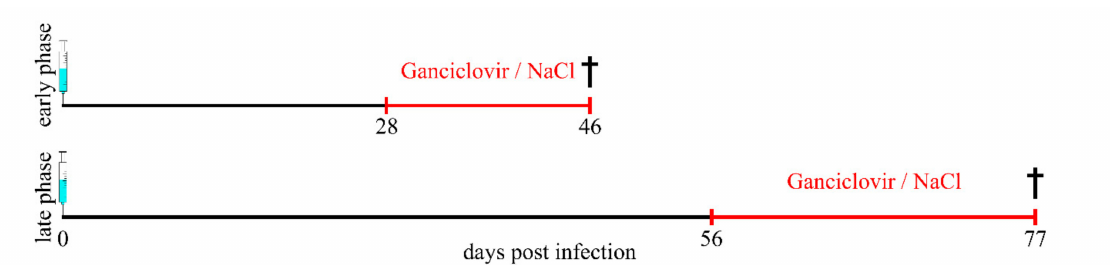
Figure 11. Study design. Groups of 2–6 GFAP-thymidine-kinase transgenic SJL mice and SJL wildtype mice were infected with Theiler’s murine encephalomyelitis virus (TMEV) or mock (vehicle only). Astrocyte depletion was induced by once daily intraperitoneal administration of ganciclovir from 28 to 46 (early phase) or 56 to 77 (late phase) days post infection. Red line indicates the ganciclovir / NaCl treatment